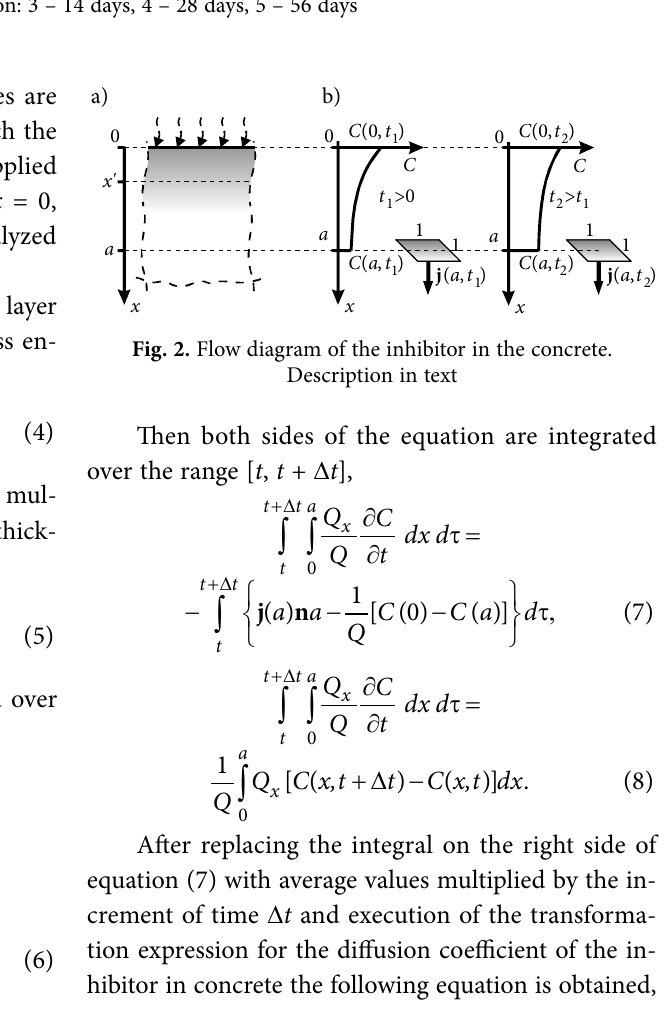
Fig. 1. Distribution of concentrations of inhibitors in concrete – DME after the application: 1 – 14 days, 2 – 28 days;